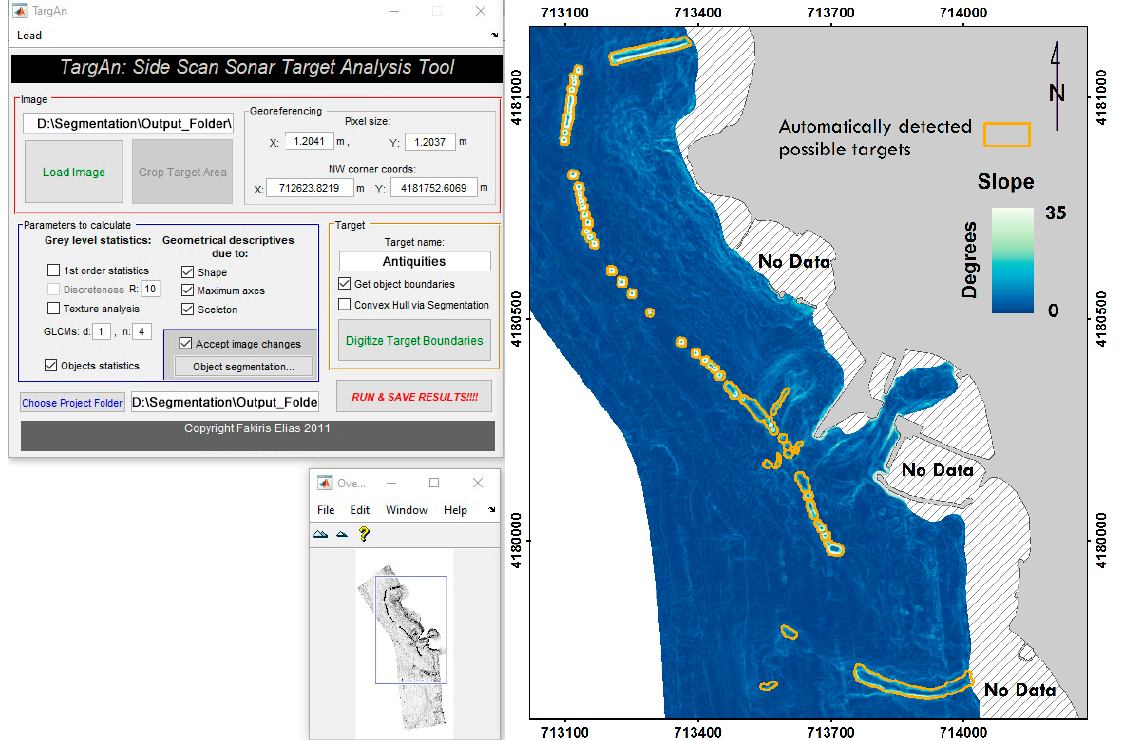
Figure 6. The TargAn software was used for the segmentation of the bathymetric slope imagery to detect any morphological anomalies in the scene (i.e., conical rubble structures, breakwaters, other artificial structures) and proceed to geostatistical parameterization.